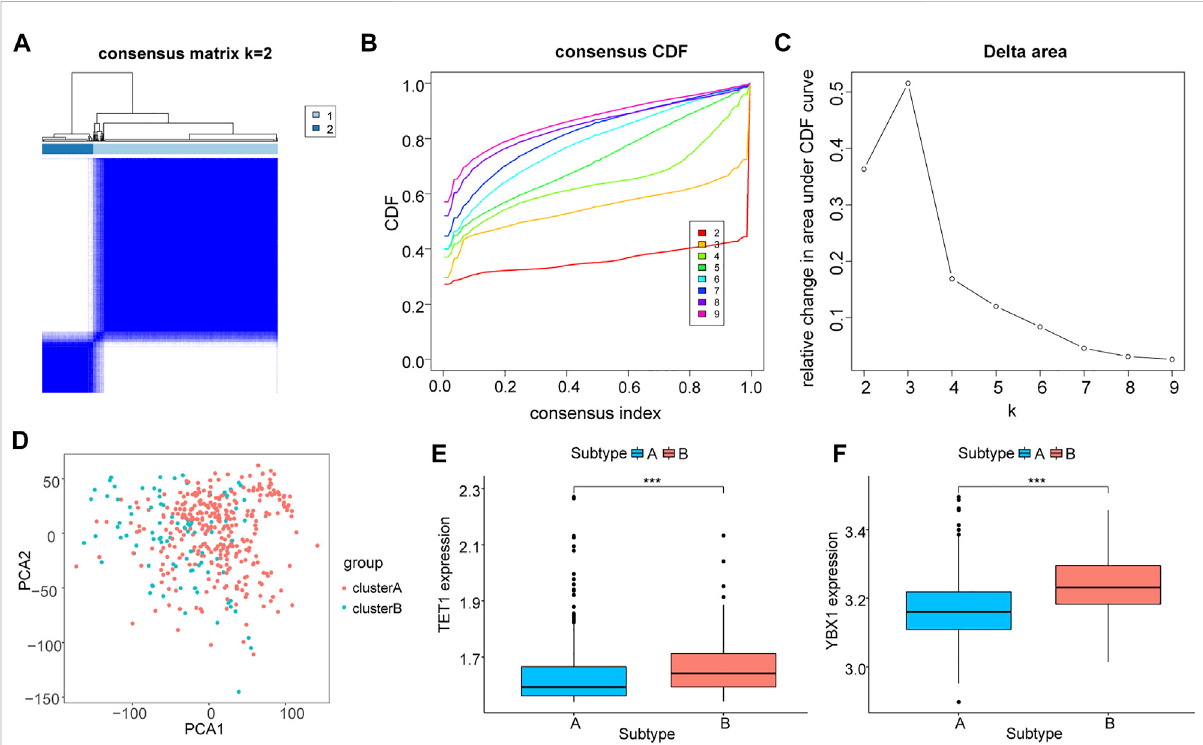
FIGURE 7 Molecular typing based on immune checkpoint genes. (A – C) : Cluster grouping based on immune checkpoint genes, (A) : sample size after grouping; (B) : change in area under the CDF curve ( k = 2 – 9); (C) : change of delta area plot when k = 2 to k = 9; (D) : PCA analysis of cluster A and B; E-F: differential expression level of TET1 (E) and YBX1 (F) in different groupings, cluster (A) in blue and cluster (B) in